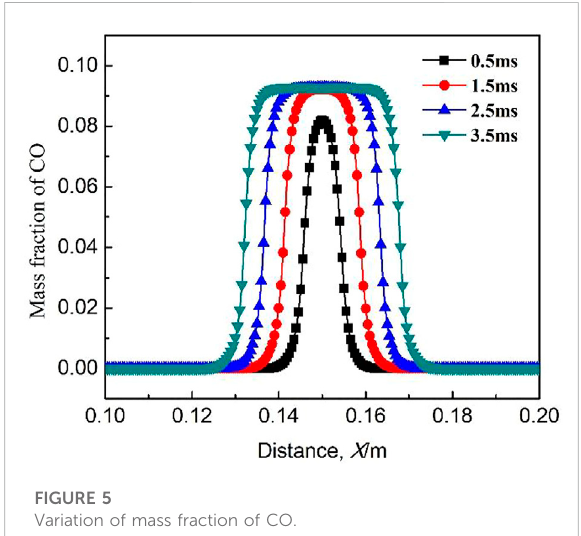
FIGURE 5 Variation of mass fraction of